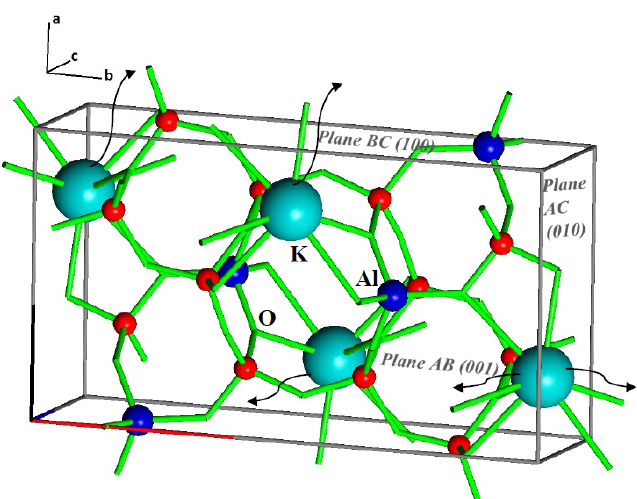
Figure A1. Simplified parallelepiped version of a primitive unit cell of microcline (chemical composition K 4 Al 4 Si 12 O 32 ). Red spheres: Si atoms; blue spheres: Al atoms; cyan spheres: K atoms; green lines: − O − links between two neighboring Si/Al atoms. Black curved arrows show potential removal paths of K + from different planes of the unit cell (namely, AB, BC and AC). We assume that all K + from half of the unit cell are available for exchange, hence only the K + nearest to a plane can potentially move out from that particular